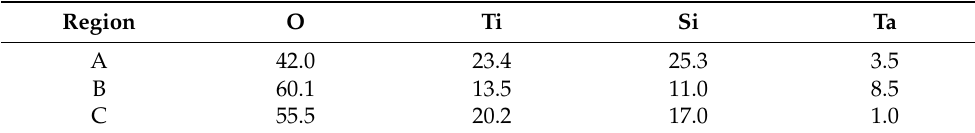
Table 4. EDS results of region A, B, and C in the enlarged image in Figure 4d (at. %). Region O